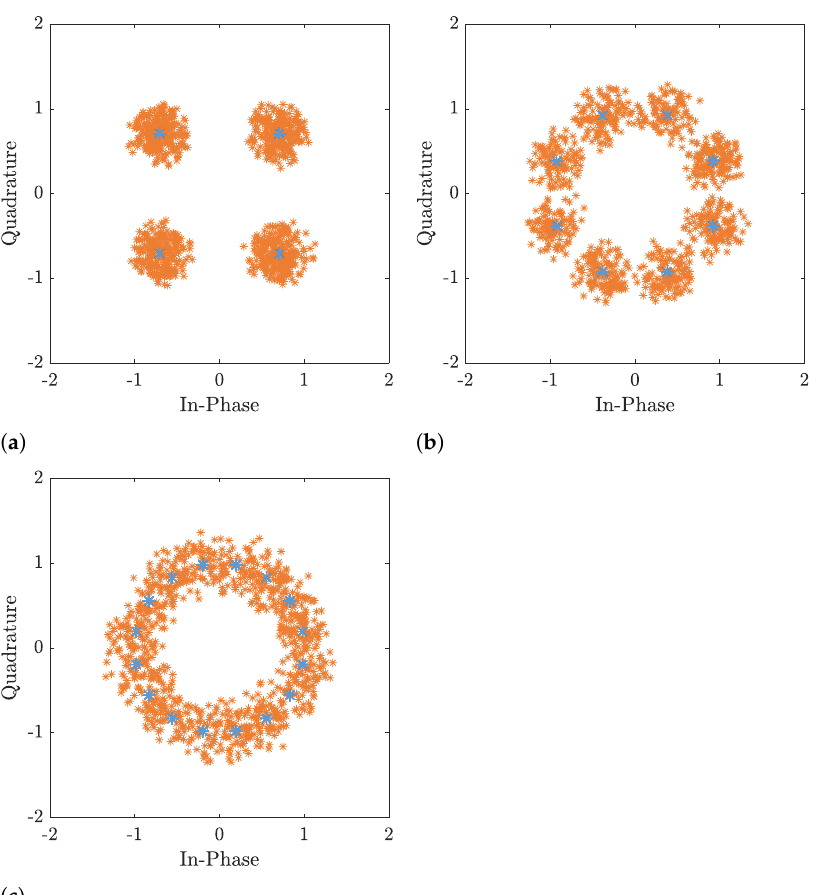
Figure 6. A constellation of transmitted symbols (blue) and received symbols in the presence of the general interferer (orange), for ( a ) 4–Phase-Shift Keying (PSK), ( b ) 8–PSK, ( c ) 16–PSK modulations, no Additive White Gaussian Noise (AWGN), and SIR = 10 dB.